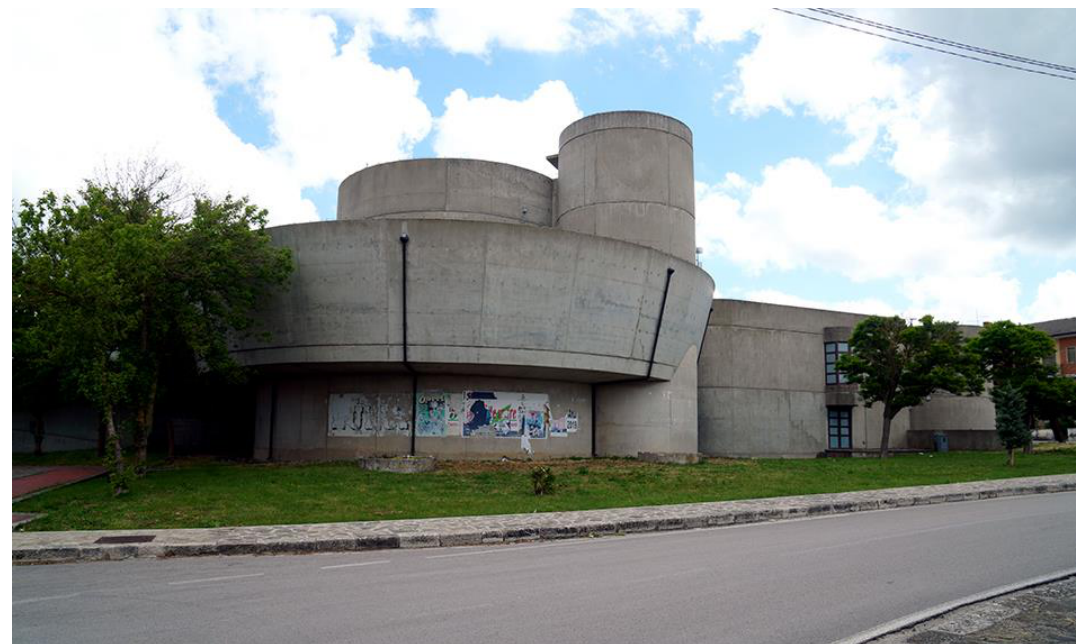
Figure 105. Bisaccia: the new village (Piano di Zona) with new Church of Sacro Cuore built by the architect A. L. Rossi, 1998 (photos by [41]).